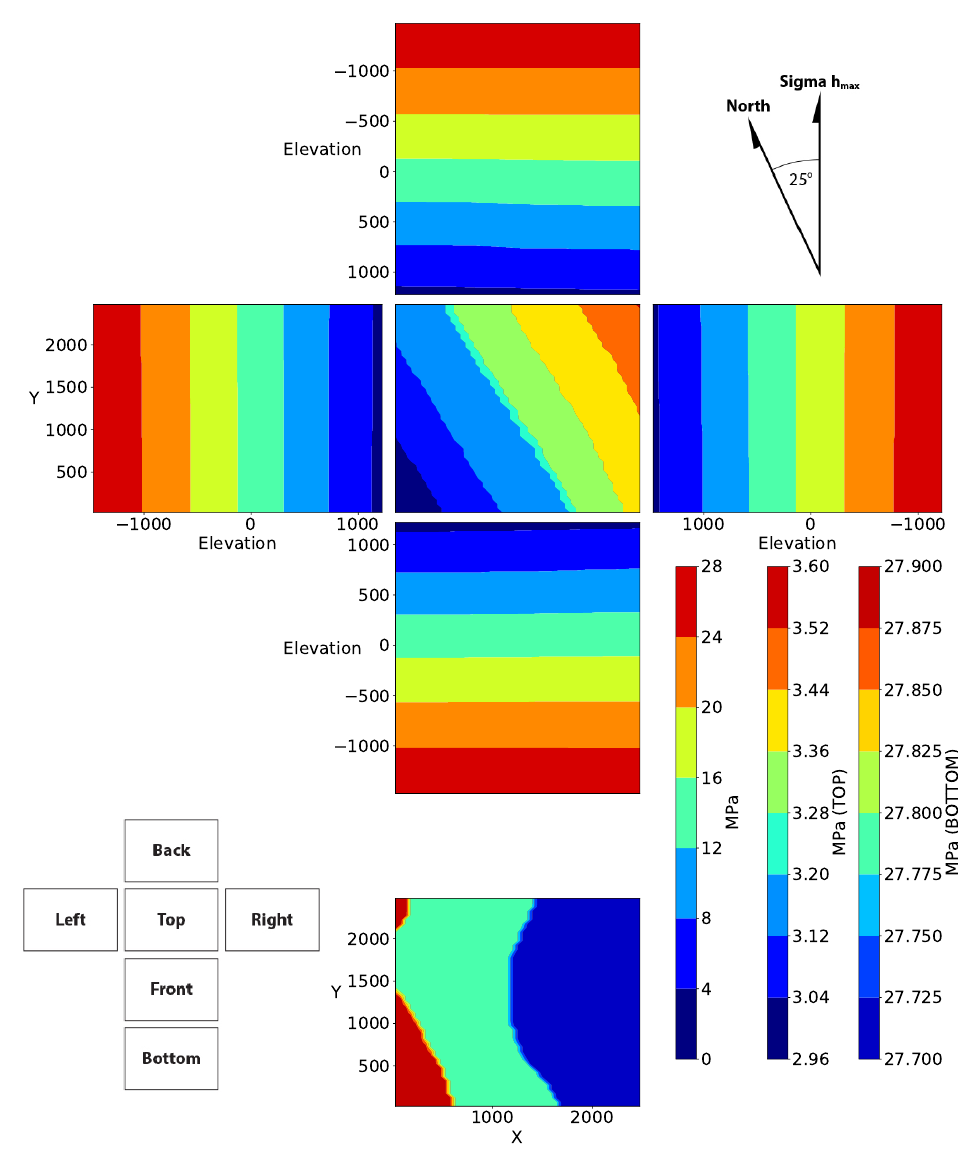
Figure 13. Native state pressure distribution. Topographic effects resulted in significant variation in vertical stress, as shown in Figure 14. The general westward slope of the land surface (i.e., thicker overburden on the eastern side of the model domain) resulted in an approximate 3 MPa difference in the stress applied to the top boundary. Superimposed on the westward slope of the ground surface was the topographic expression of the Mag Lee Wash. The effects of both the slope and wash are reflected in the predicted vertical stress on the bottom surface of the